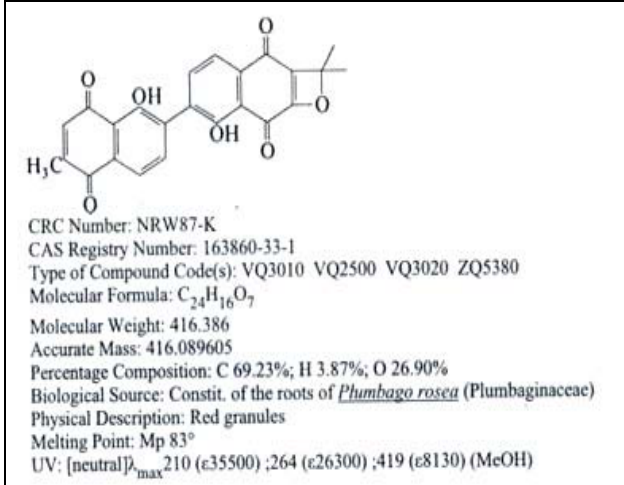
H O ), mol wt = 416.386 24 16 7